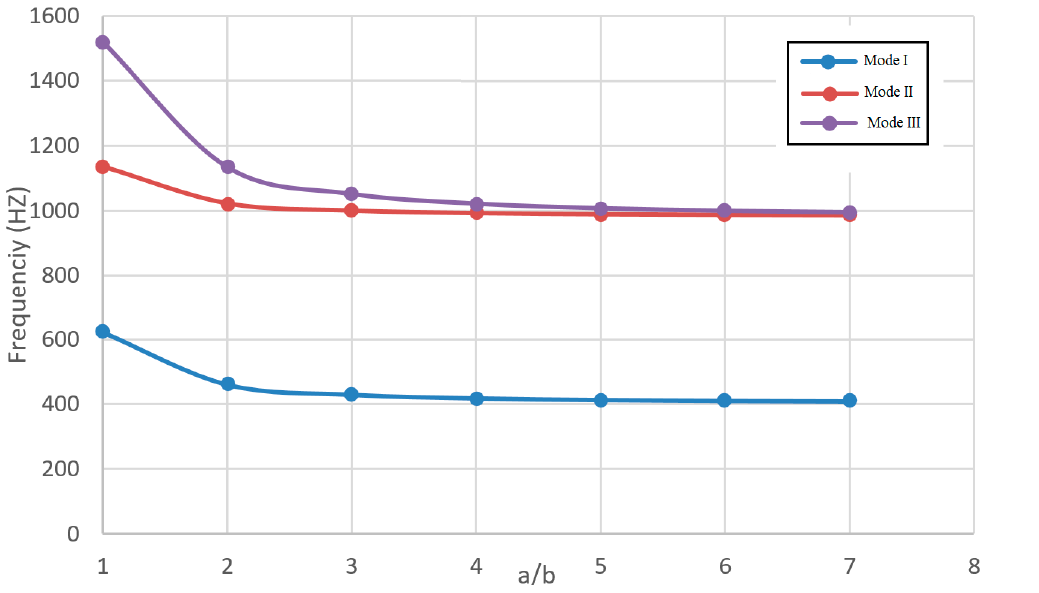
= 1 , (cid:3035) (cid:3117) = 0.1 (cid:3035) (cid:3118) = (cid:3035) (cid:3035) (cid:3029)